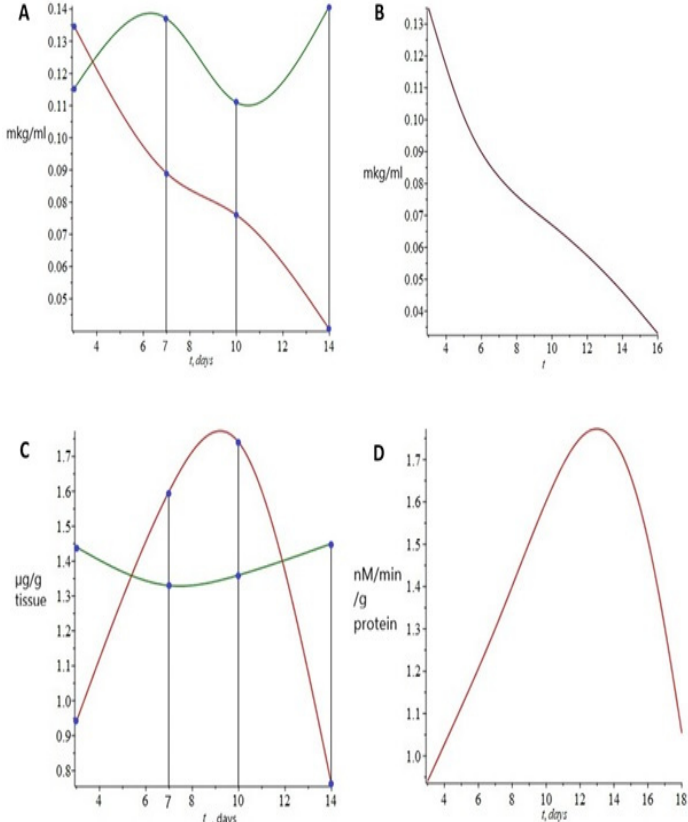
Figure 5. Plasma corticosterone concentration ( A ) and brain MAO-A activity ( C ) during the post- stress period for stressed rats (red points) and control rats (green points). The points have been connected by spline interpolation (red and green lines). Plasma corticosterone concentration ( B ) and brain MAO-A activity ( D ) predicted by the mathematical model for the stressed rats are illustrated by continuous red lines.